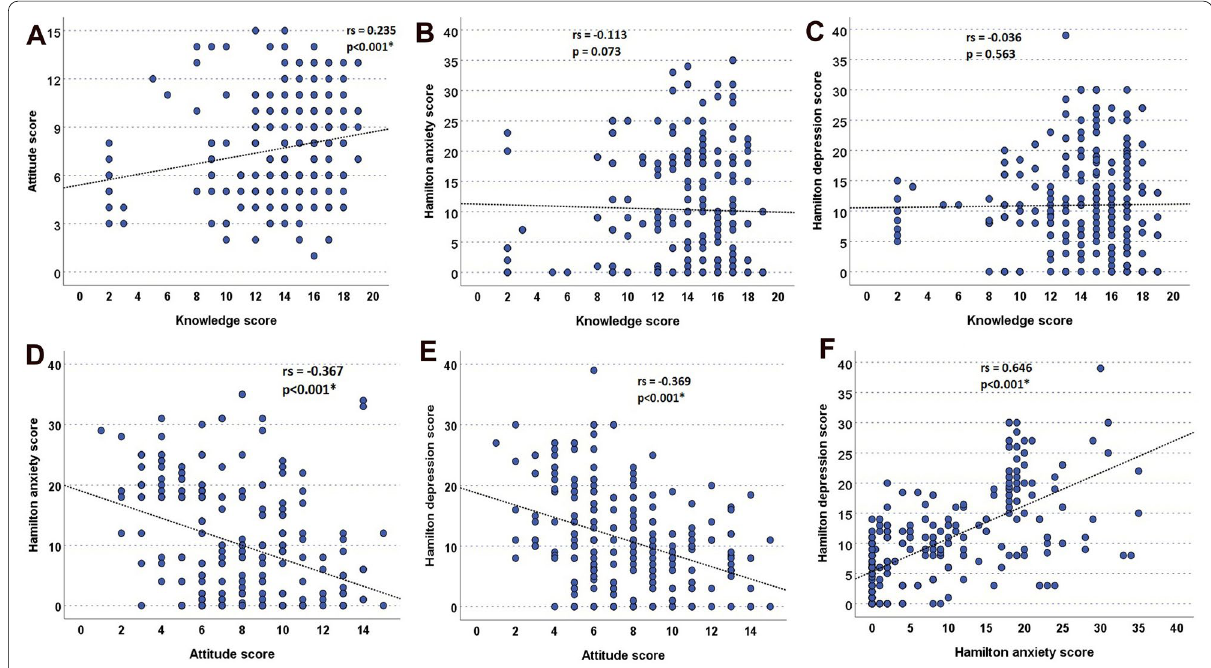
Figure. 1: Correlations between the studied scores